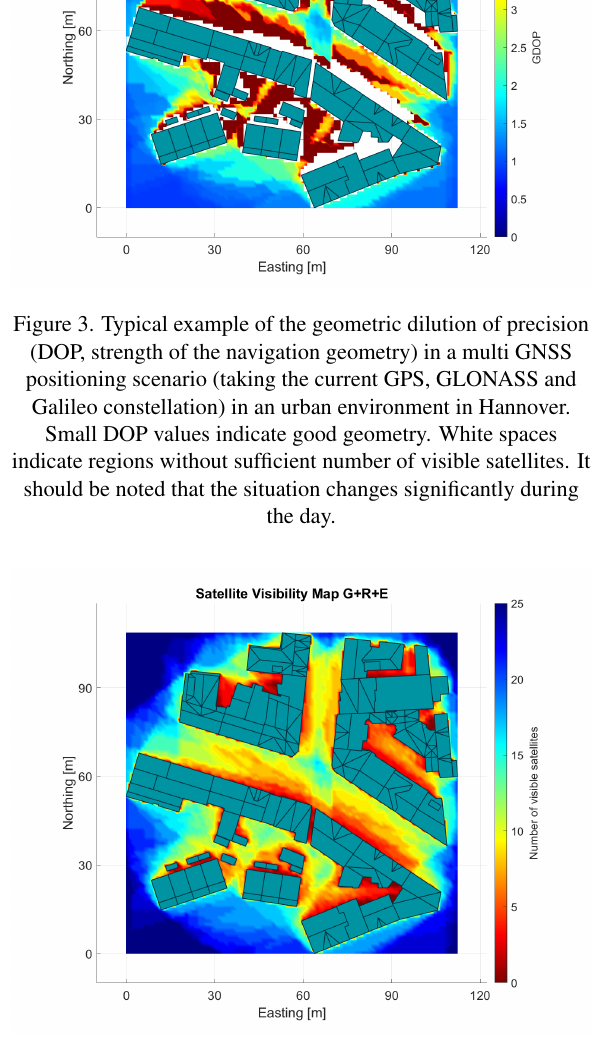
Figure 4. Example of multi GNSS (GPS, GLONASS, Galileo) satellite visibility in an urban environment in Hannover with building heights of 15 m to 21 m of the problem should be